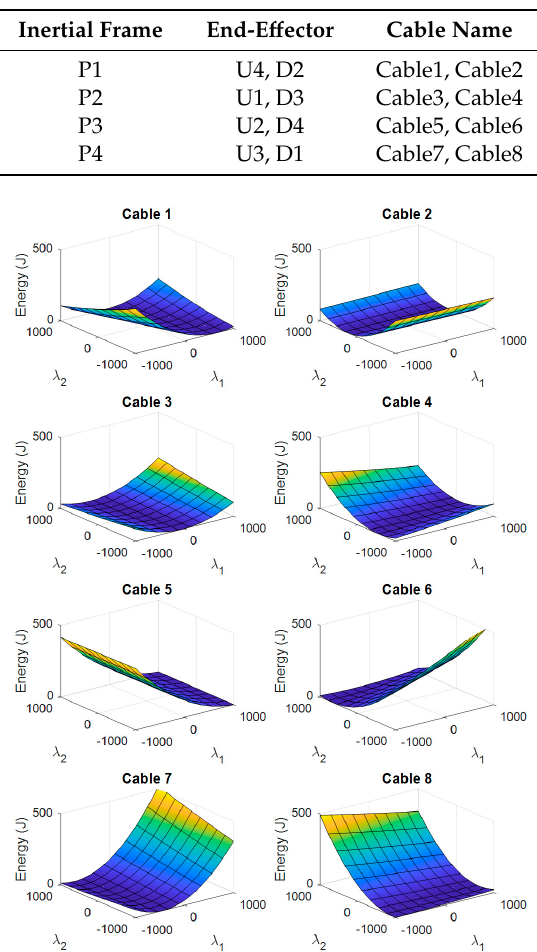
Figure 5. Figure 5. Surface corresponding to the potential energy of each cable as a function of the nullspace variables.